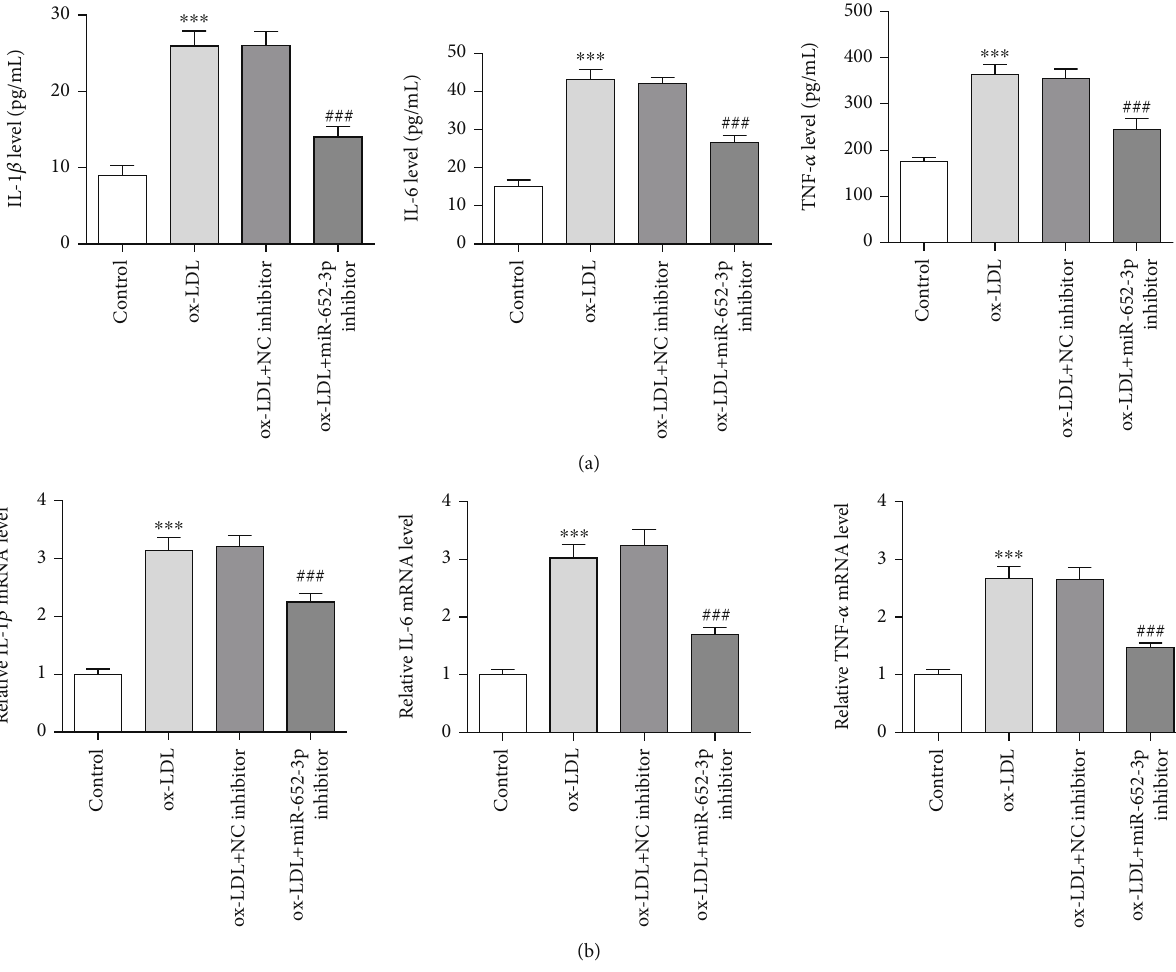
Figure 2: Knockdown of miR-652-3p attenuates in fl ammation in ox-LDL-treated macrophages. (a) Q-PCR assay for detecting IL-1ß, IL-6, and TNF- α levels. (b) ELISA assays were undertaken to detect the expression of immune factors vs. control group, ∗∗∗ P < 0 : 001 vs. ox-LDL +NC inhibitor group, ### P < 0 : 001